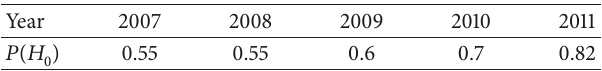
Figure 6: The historical data of the year 2011 of low-voltage switchgear. Table 1: The prior probability 𝑃(𝐻 0 ) of the year from 2007 to 2011.